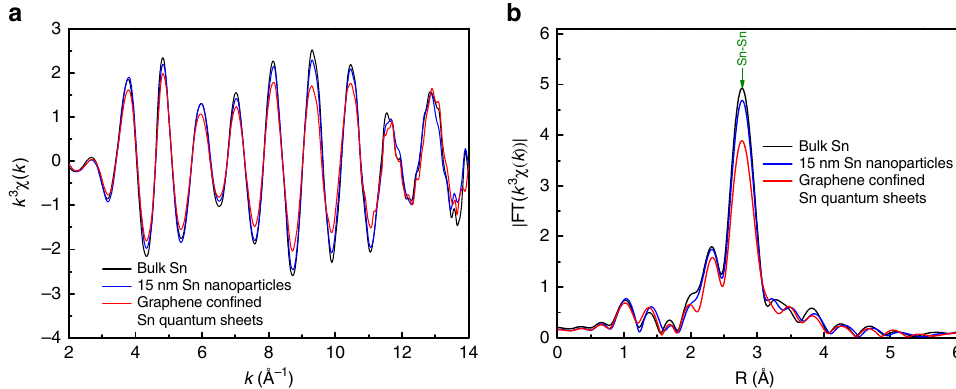
Figure 3 | Synchrotron radiation XAFS measurements. ( a ) Sn K-edge extended XAFS oscillation function k 3 w ( k ), ( b ) the corresponding Fourier transforms FT( k 3 w ( k )) for the graphene confined Sn quantum sheets, 15nm Sn nanoparticles and bulk Sn, respectively.